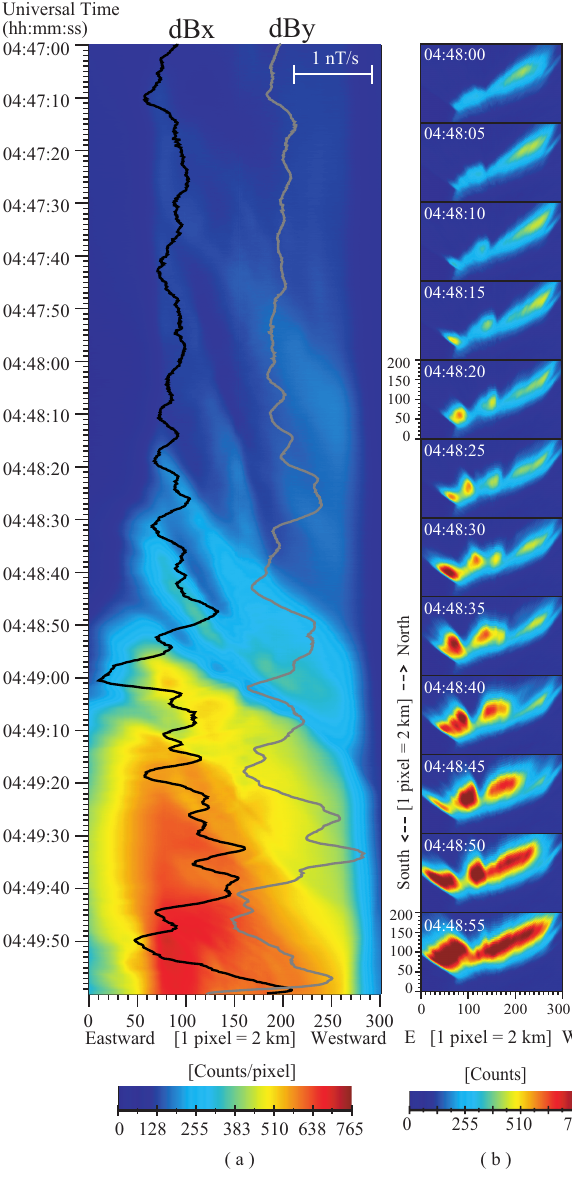
Fig. 6. (a) Temporal variation of brightening auroras in an east-west cross section from 04:47UT to 04:50UT on 8 January 2008 at Fort Smith. The vertical axis is time increasing downward. The hor- izontal axis is distance [km]. The black and gray lines are X- and Y-components magnetic field fluctuations (40-s running average are subtracted) observed by a search coil magnetometer. (b) Brighten- ing auroral images (0.1s averages) every 5s from 04:48:00UT to 04:48:55UT. The east-west keogram in (a) was obtained by inte- grating the images in (b) over the whole Y-axis distance.